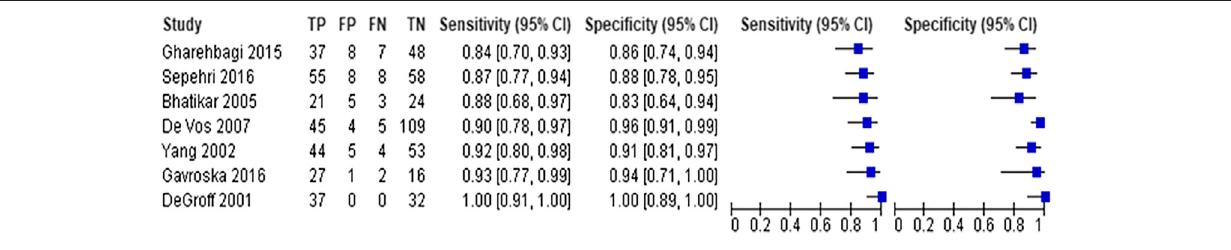
FIGURE 3 | Forest plot for neural network models (arranged by increasing order of sensitivity).